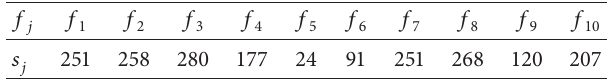
Table 2: Size files values for the case study.